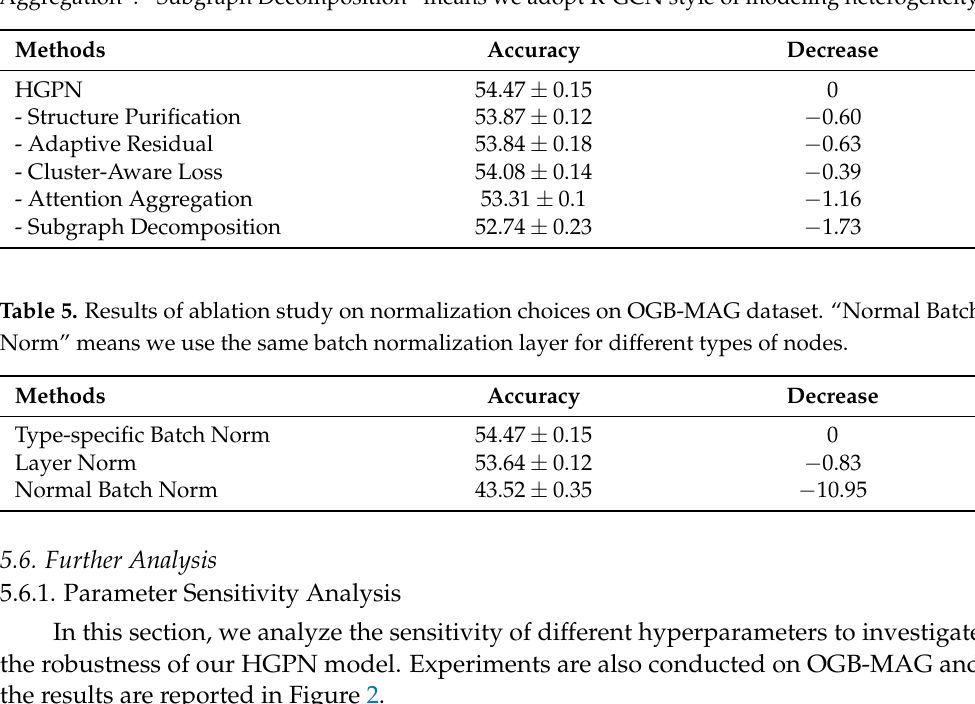
Table 4. Results of ablation study on HGPN’s novel design in OGB-MAG dataset. We use normal residual connection and mean-pooling instead of “Adaptive Residual Update” and “Attention Aggregation”. “Subgraph Decomposition” means we adopt R-GCN style of modeling heterogeneity.